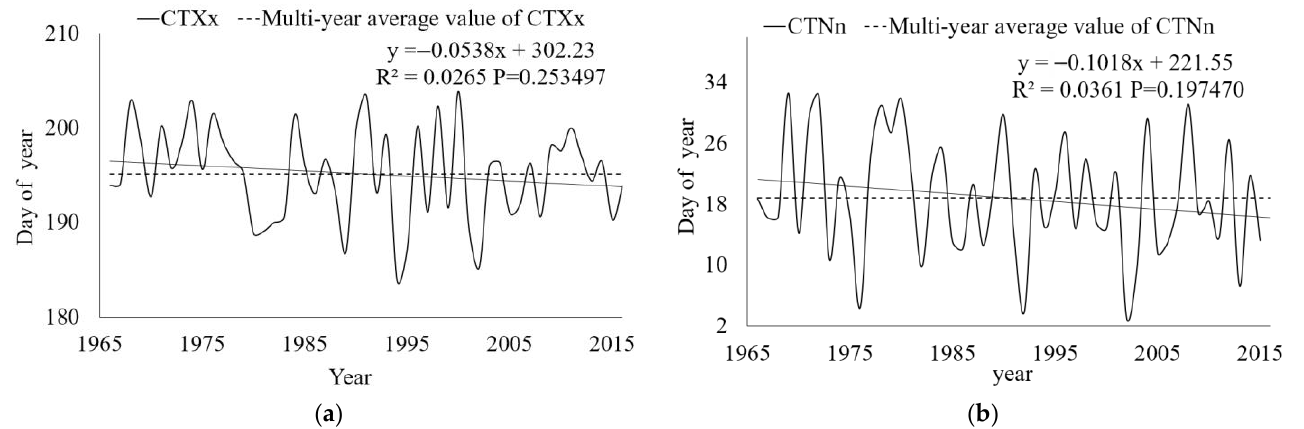
Figure 6. Temporal changes in CTXx and CTNn in China, 1966 – 2015. ( a ) CTXx. ( b ) CTNn. Spatially, CTXx is significantly delayed in the Qinghai-Tibet Plateau, northern China, southern Xinjiang, and northeast China, and significantly advanced in the central Yunnan, Guizhou, and Guangxi junctions.The CTNn delayed arrival region was distributed in the Qinghai-Tibet Plateau, Gansu Hexi Corridor, northern Ningxia, northern Shaanxi, northern Shanxi and western Inner Mongolia, while the advance of CTNn was mainly in the northeast, Beijing-Tianjin-Hebei region and the Sichuan, Yunnan and Guizhou (Figure 7).